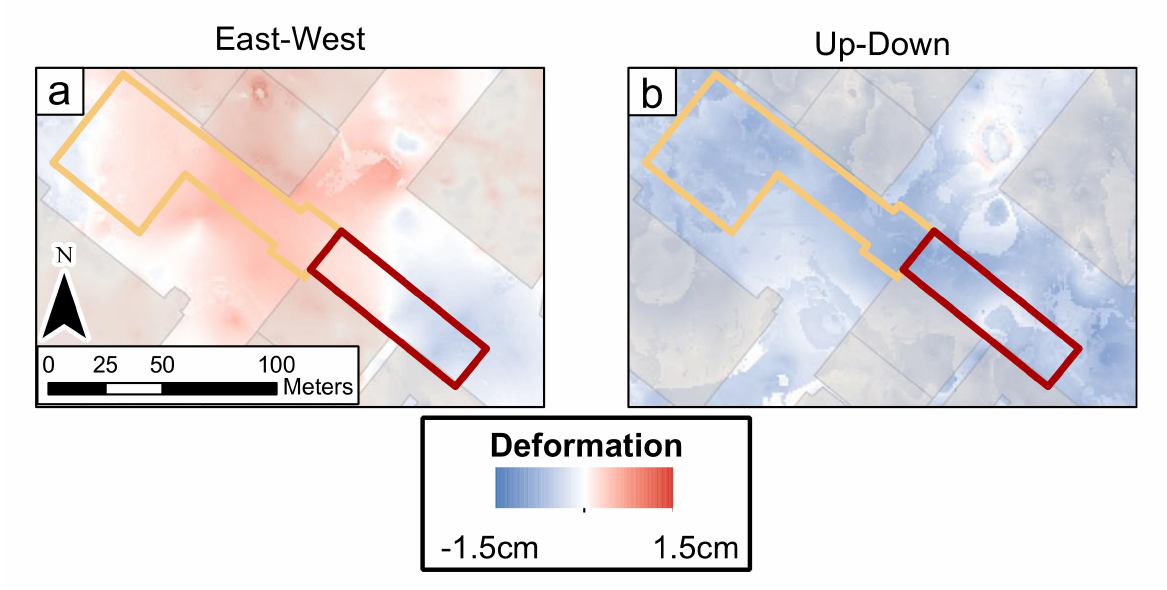
Figure 10. ( a , b ) Vertical and East-West horizontal deformation spanning initial crossover cavern excavation from 5 June 2018 to 11 November 2018. Displacement measured by combined Sentinel-1 and COSMO-SkyMed time-series.